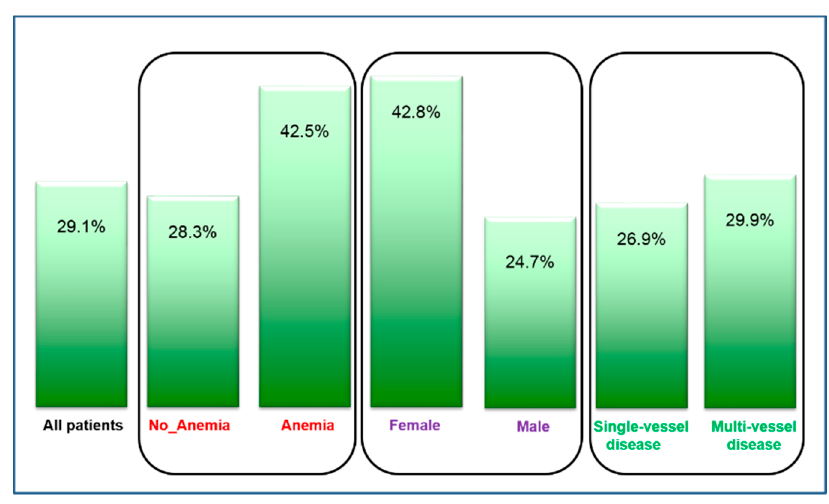
Figure 1. Prevalence of iron deficiency across subgroups of acute coronary syndrome. Table 1. Baseline characteristics of the study patients.